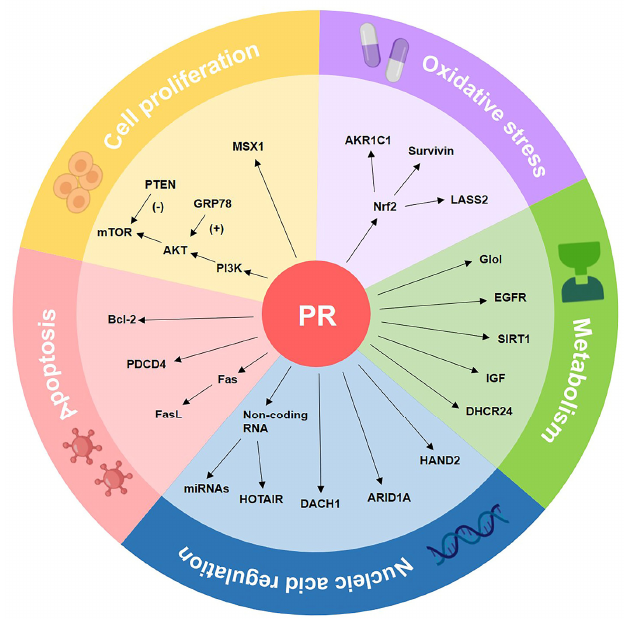
Figure 4. The molecular biomarkers of progestin resistance. Numerous biomarkers may be catego- rized into five basic groups: molecules linked to cell proliferation, molecules related to oxidative stress, molecules related to metabolism, molecules related to the apoptosis pathway, and nucleic acid regulation-related biomarkers. Table 1. The markers of progestin resistance.